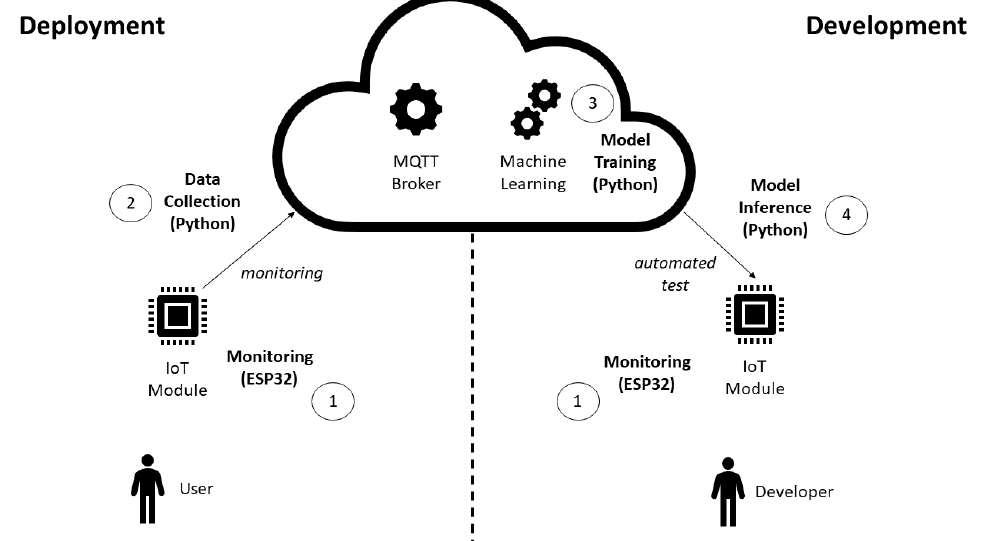
Figure 2. Proposed TDD scheme for IoT with automated